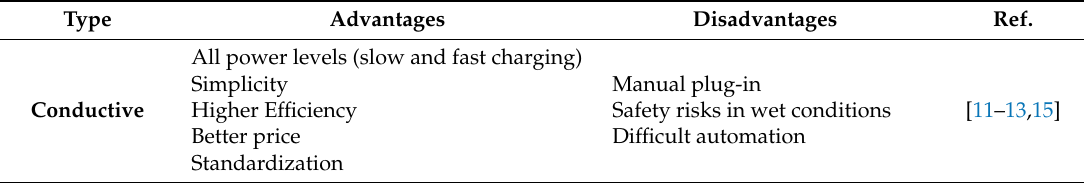
Table 1. Comparison between conductive and inductive chargers.